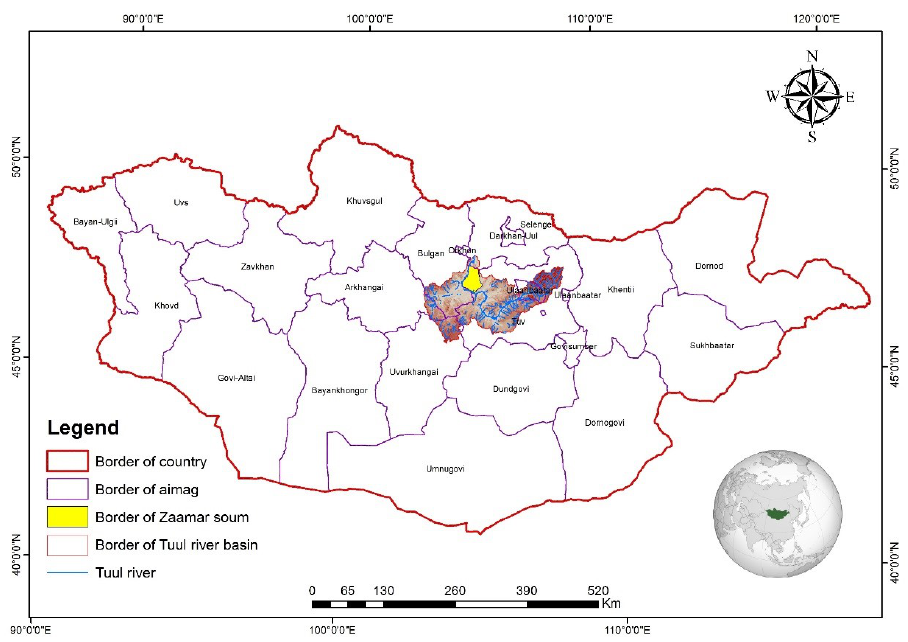
Figure 1. Geographic location of study